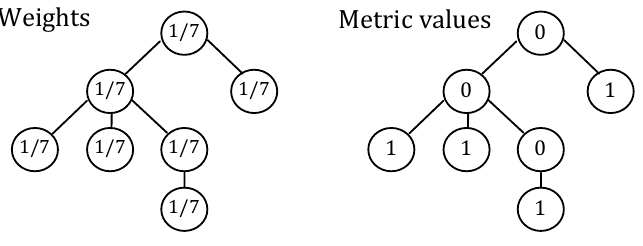
Fig 7. Calculation of the “percentage of leaves” as a node-based sentence metric. In this example the result is 1/7x1+1/7x0+1/